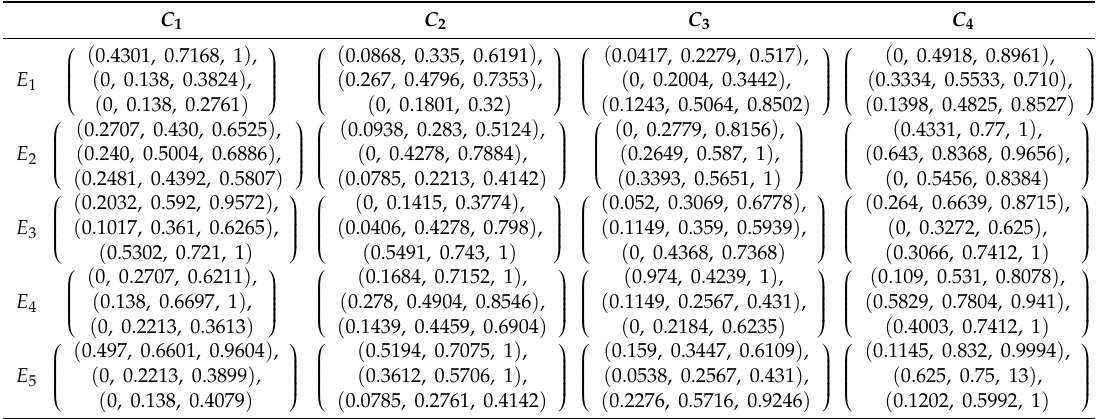
Table 6. The weighted normalized TFNNs decision matrix P .